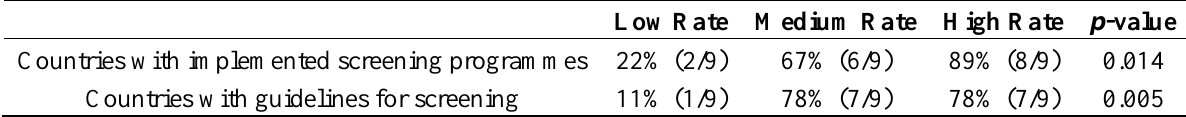
Table 1. Association between the rate of asylum-seekers in the population and the implementation of screening programmes and guidelines for screening.